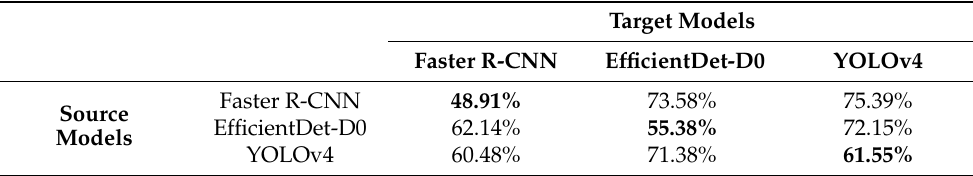
Table 9. mAP of each target object detection model using the